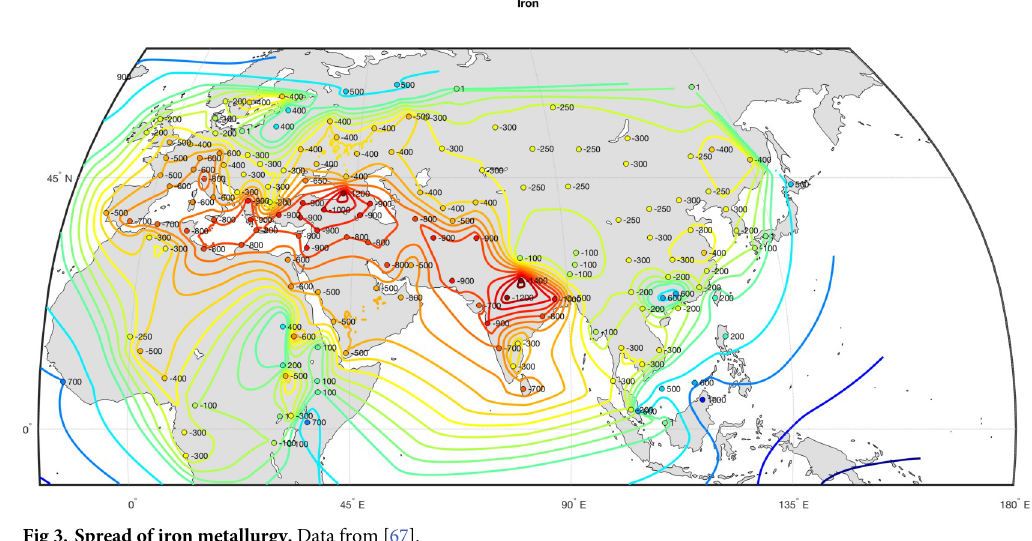
Fig 3. Spread of iron metallurgy. Data from [67].